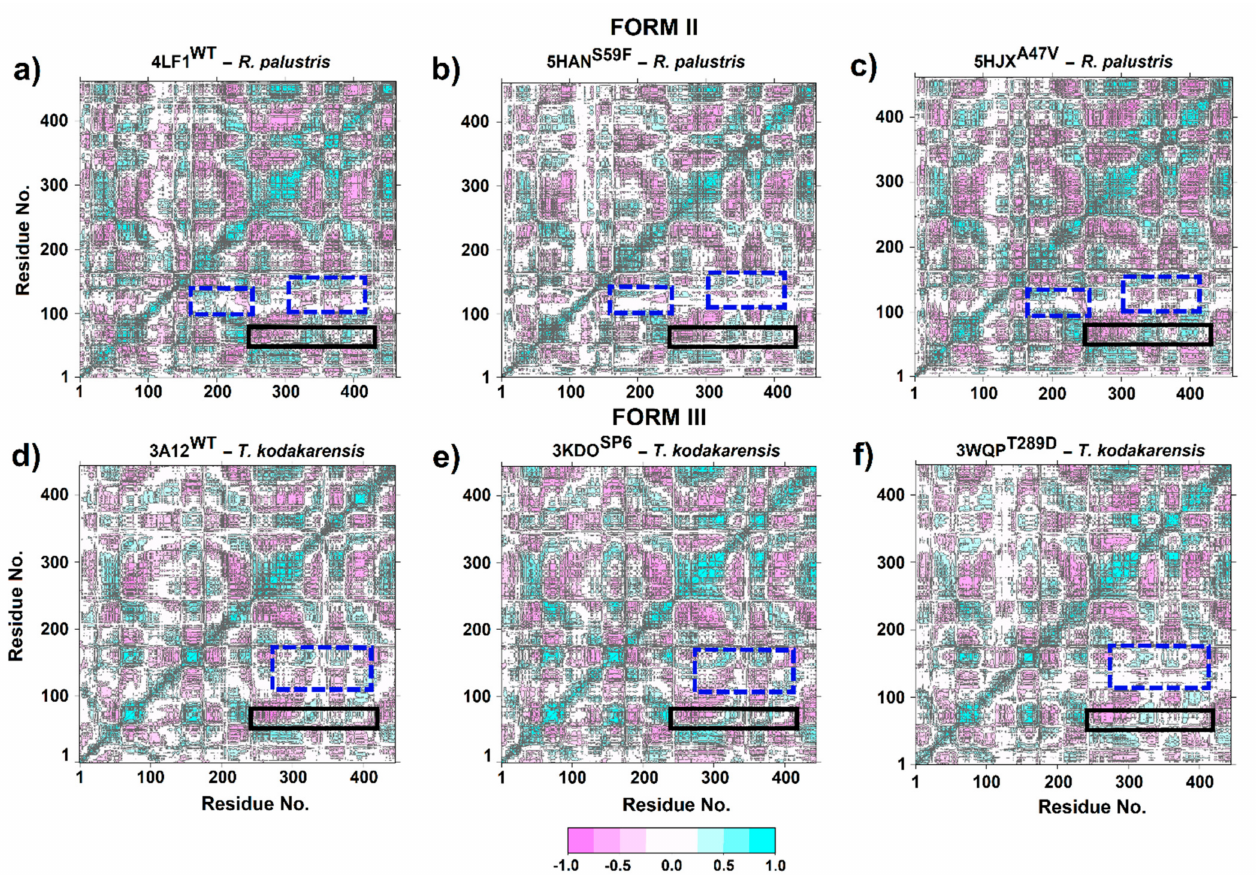
Figure 9. Cross-correlation analysis (DCCM) of RuBisCO form II ( R. palustris ) and III ( T. kodakarensis ). ( a ) 4LF1 WT ( R. palustris ); ( b ) 5HAN S59F ( R. palustris mutant); ( c ) 5HJX A47V ( R. palustris mutant); ( d ) 3A12 WT ( T. kodakarensis ); ( e ) 3KDO SP6 ( T. kodakarensis mutant); and ( f ) 3WQP T289D ( T. kodakarensis mutant). The color scale ranges from pink (for values ranging from − 1 to − 0.5) to white ( − 0.5 to 0.5) and to cyan (0.5 to